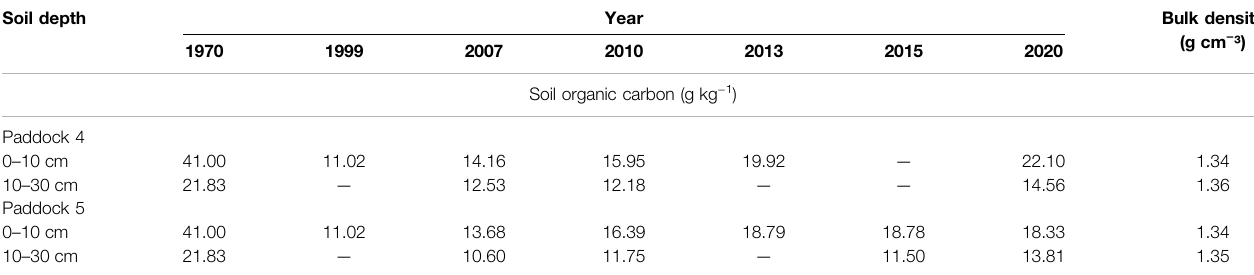
TABLE 3 | Soil bulk density and soil organic carbon content of each soil depth at Santo Antônio de Goiás, Goiás State, Brazil. Soil